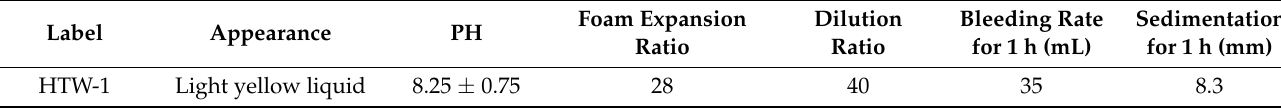
Table 3. Characteristics of compound foam agent.